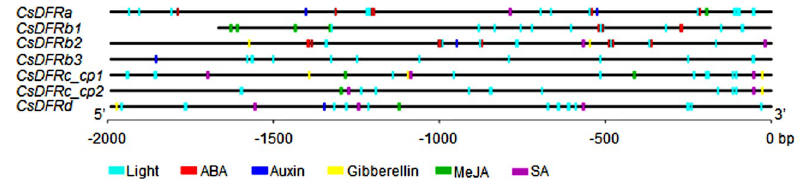
Fig 8. Promoter analysis of CsDFR genes. Black lines indicate promoter regions. Cis-acting elements involved in response to light and phytohormones are represented by color boxes.